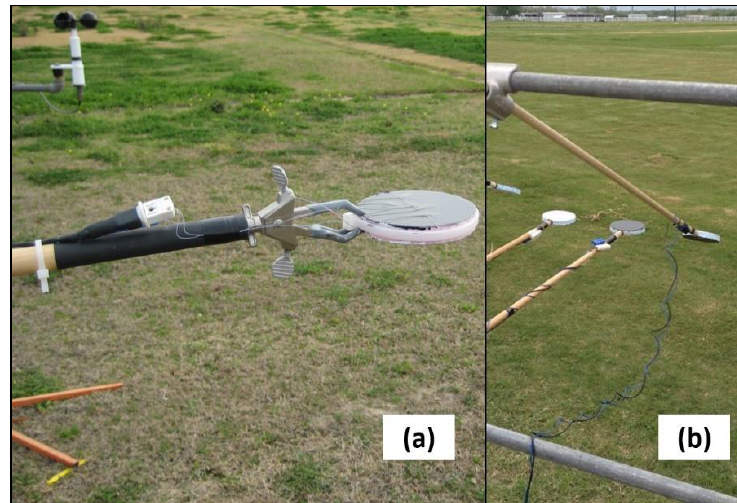
Figure 3. Discs built by students as part of their class project.; ( a ) close-up picture of a disc with its upper surface painted black and ( b ) picture of discs with upper surfaces coated with black and white paint. Discs were set up above a turf grass field for the class activity.